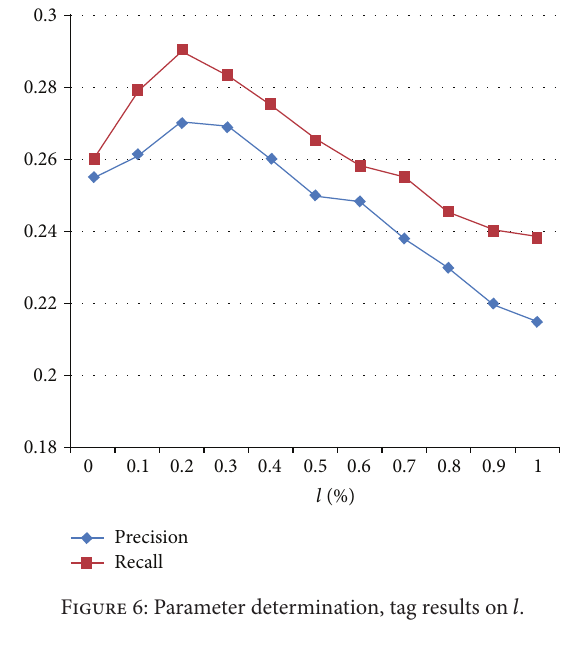
Figure 6: Parameter determination, tag results on 𝑙 .